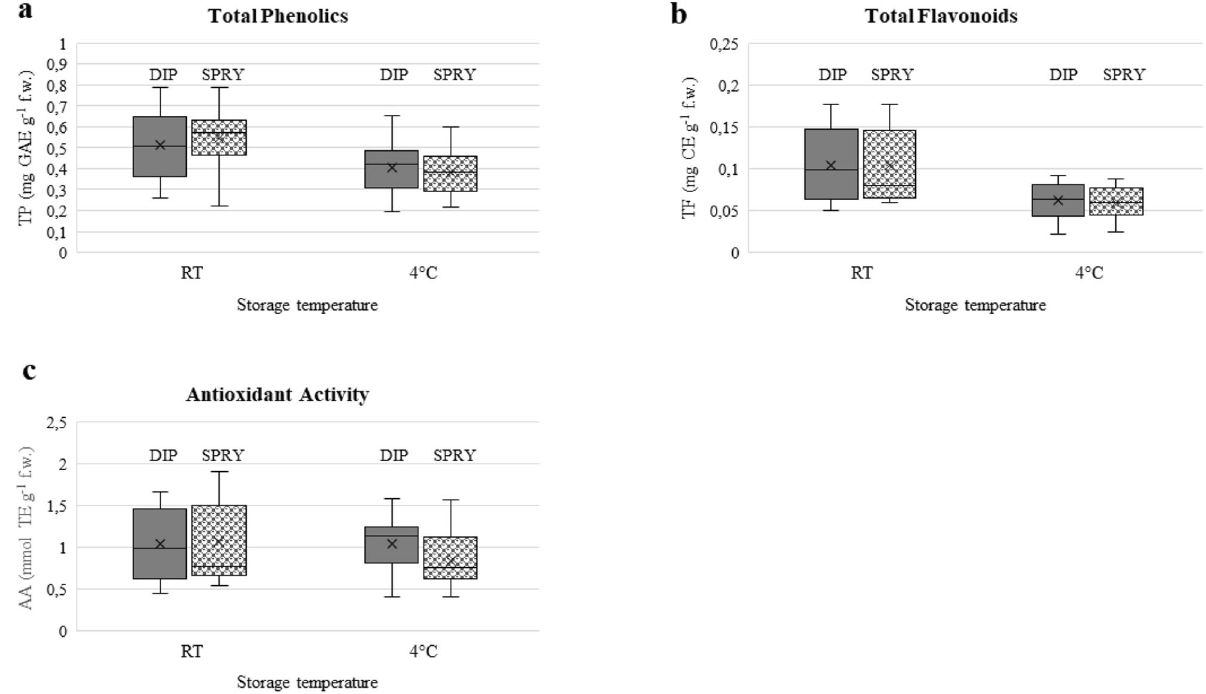
Figure 3. Box plots representing the variation in the concentration of total phenolics ( a ) and total flavonoids ( b ), and in antioxidant activity ( c ) of tomatoes depending on the coating application method (dipping or